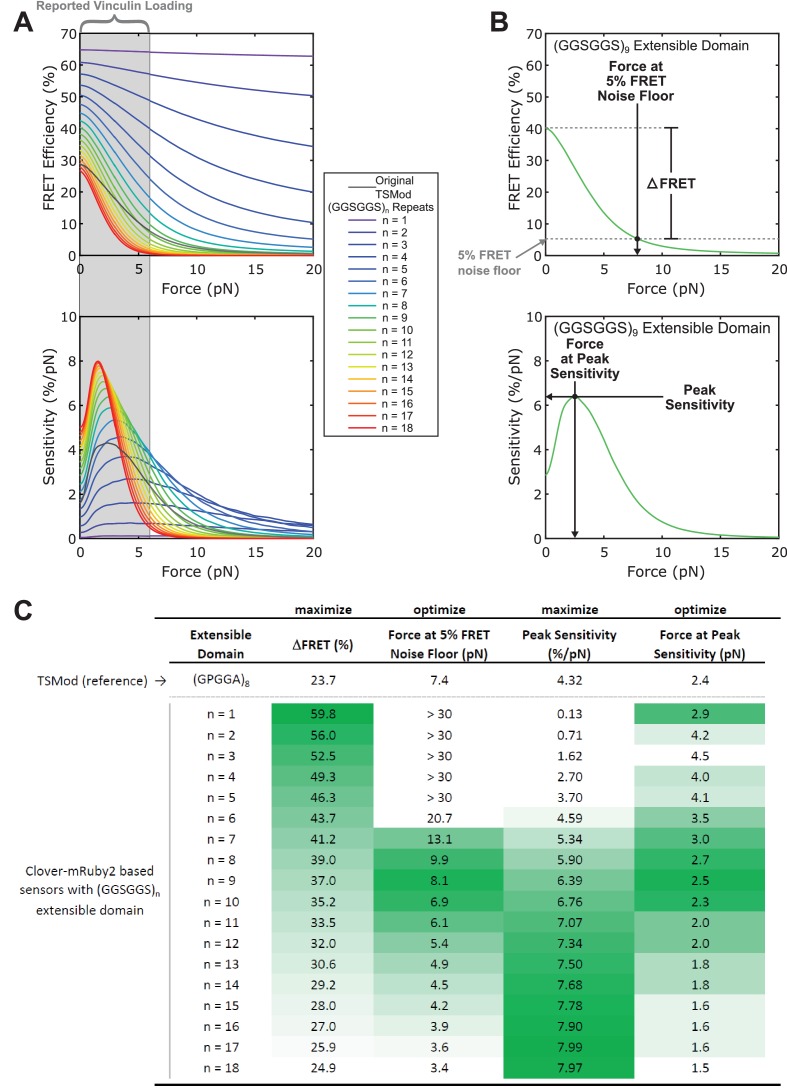
Selection of optimal (GGSGGS)n extensible domain length in a Clover-mRuby2 based TSMod for measuring ~1-6 pN loads borne by vinculin.(A) Predicted force sensitivities of TSMods containing “minimal” Clover-mRuby2 FRET pair and (GGSGGS)n extensible domains (n =1 to 16). (B) Schematic of metrics used to quantify and compare different aspects of TSMod mechanical sensitivity, which describe sensor sensitivity (ΔFRET, top; Peak Sensitivity, bottom) and functional force measurement regimes (Force at 5% FRET noise floor, top; Force at Peak Sensitivity, bottom) (C) Graphical comparison of TSMod mechanical sensitivity properties; green indicates favorable value for a given metric. Nine-repeat (GGSGGS)n extensible domain shows similar force range as original TSMod (columns 2, 4) as well as a good balance between ΔFRET (column 1) and Peak Sensitivity (column 3), which are inversely proportional.